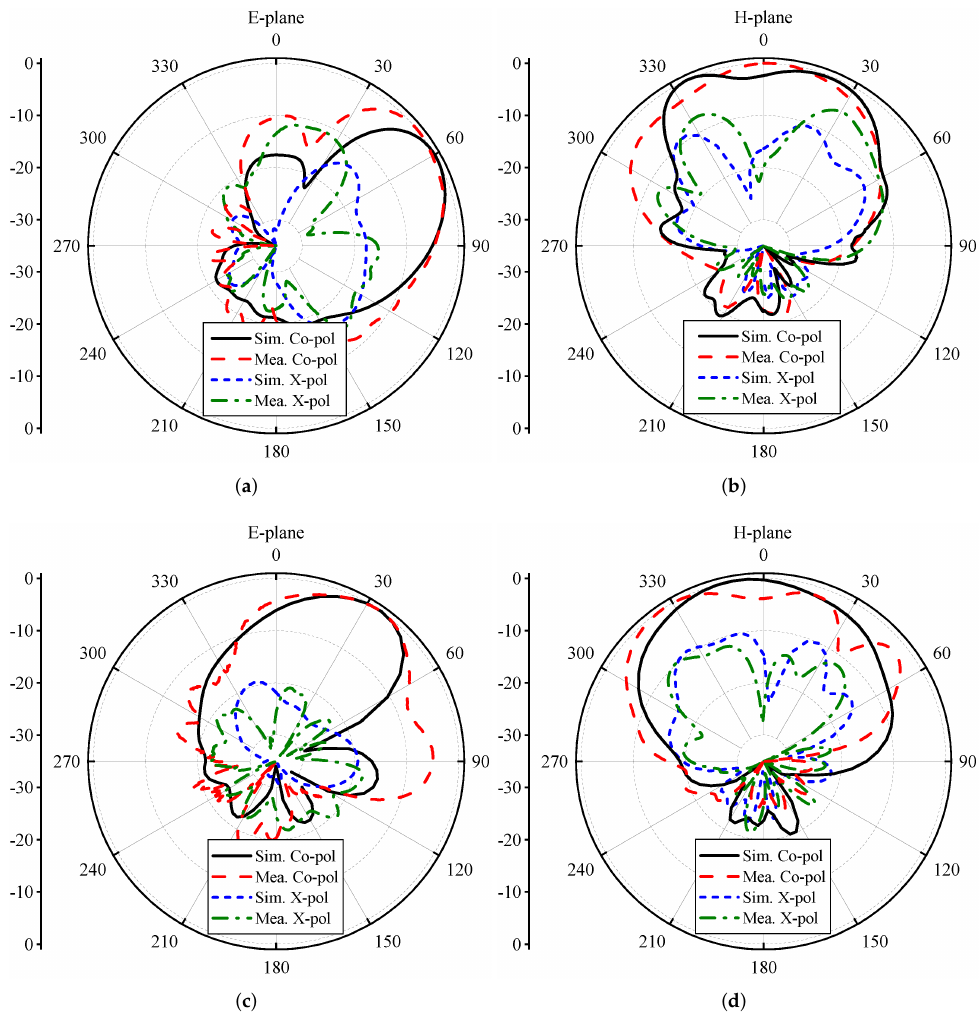
Figure 8. Radiation characteristics of the proposed Kirigami MIMO antenna for ( a , b ) antenna 1 and ( c , d ) antenna